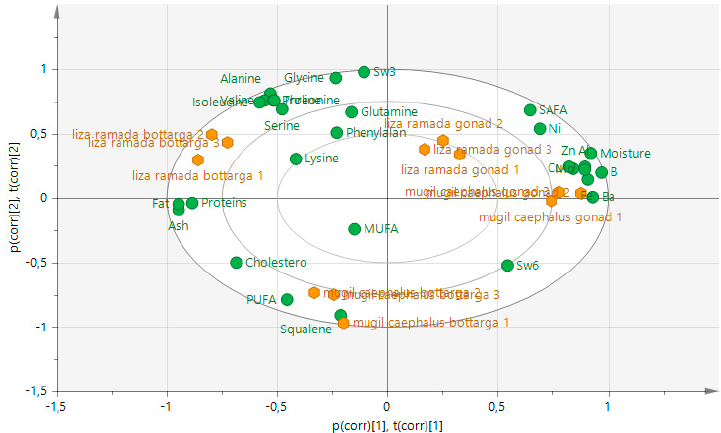
Figure 1. Principal component analysis (PCA) score scatter biplot of fresh gonads and bottarga from the two mullet species.